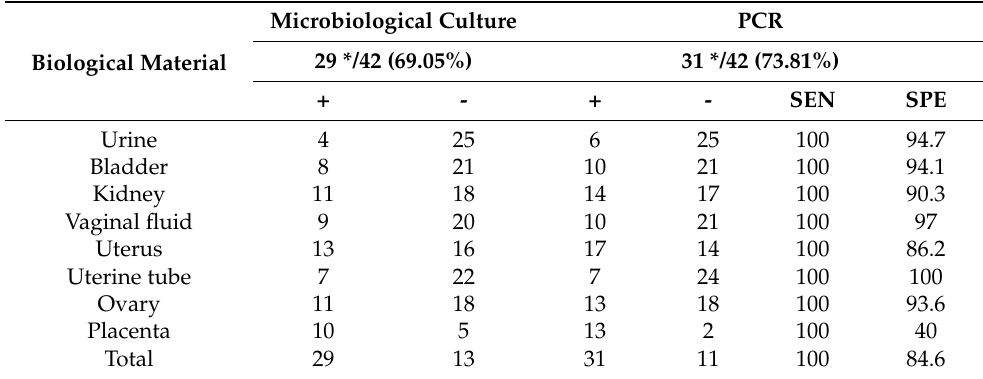
Table 3. Performance of molecular tests for diagnosing Leptospira spp. infection in cattle from the Caatinga biome, Brazil, based on the microbiological result as the gold standard.